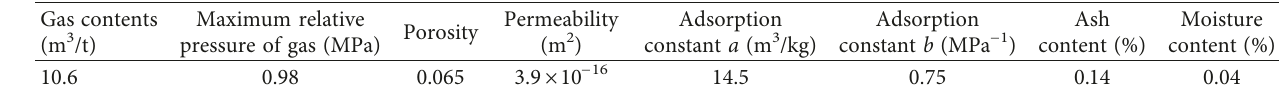
Table 2: Coal seam